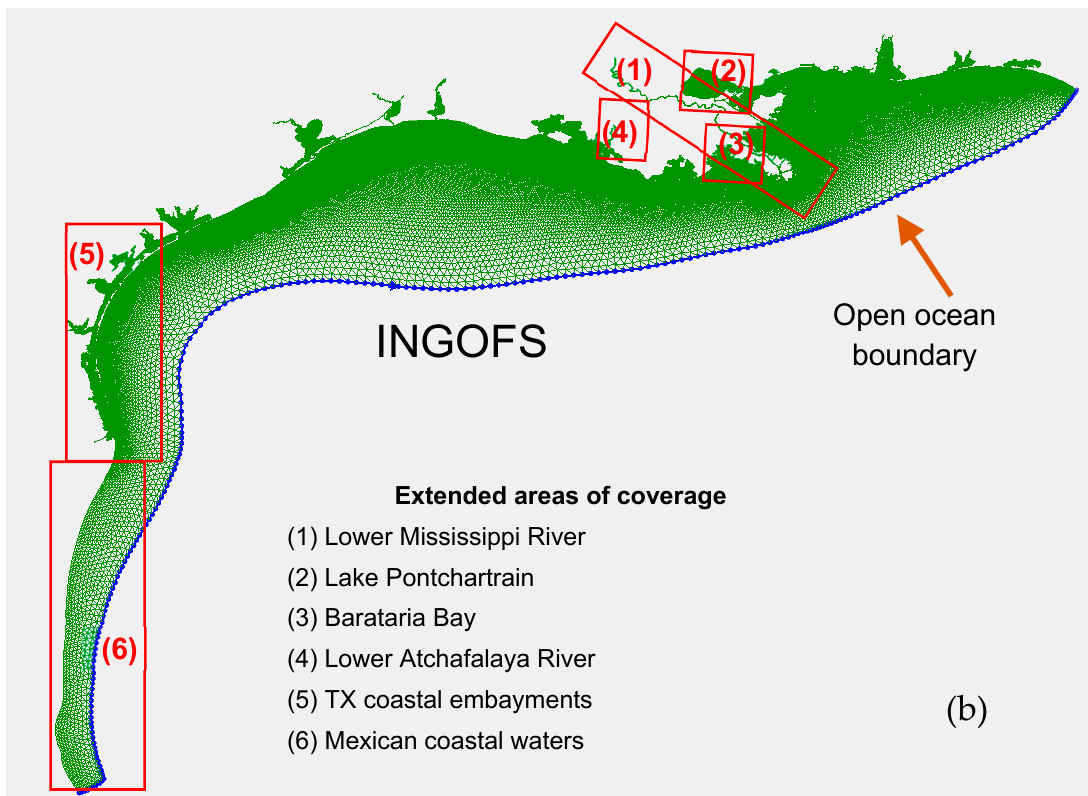
Figure 2. Model grids. ( a ) Combined grids of three existing OFS, and ( b ) the INGOFS grid. Table 1. Dimension and resolution of NGOFS, NWGOFS, NEGOFS, and INGOFS model grids. Model Number of Nodes Number of Model